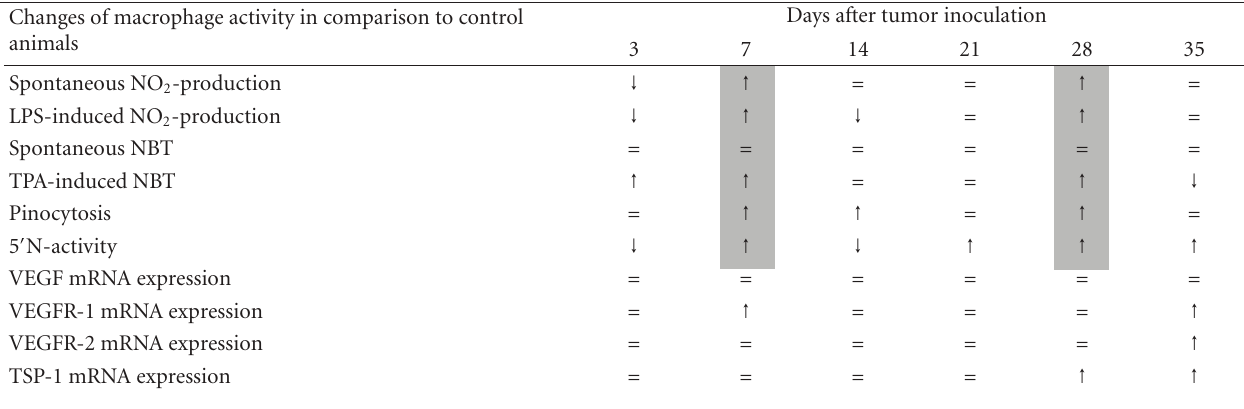
Table 3: Changes in macrophage activity during the growth of hepatoma